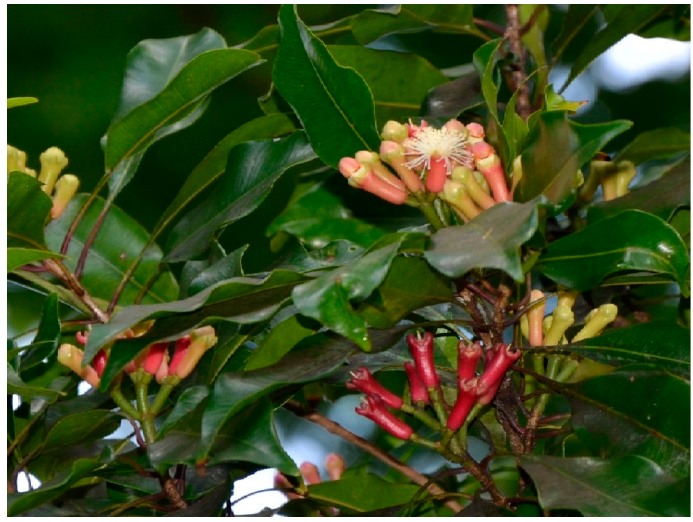
Figure 7. Image of Syzygium aromaticum plant. Source: [109].